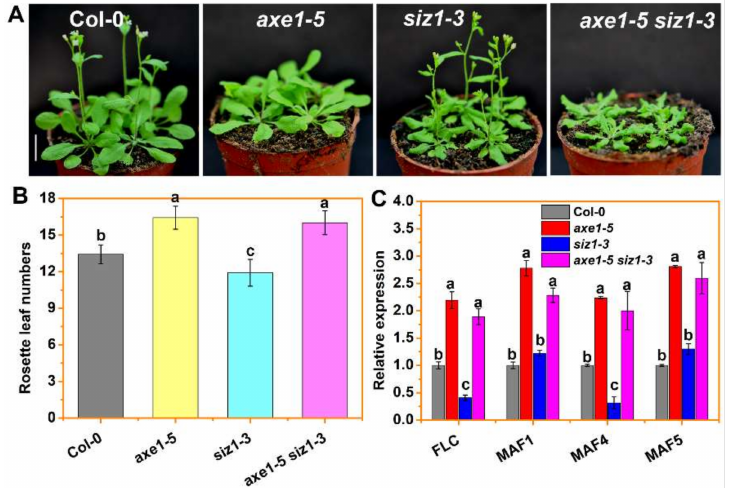
Figure 2. HDA6 acts downstream of SIZ1 to repress FLC and MAF4 . ( A ) Flowering phenotypes